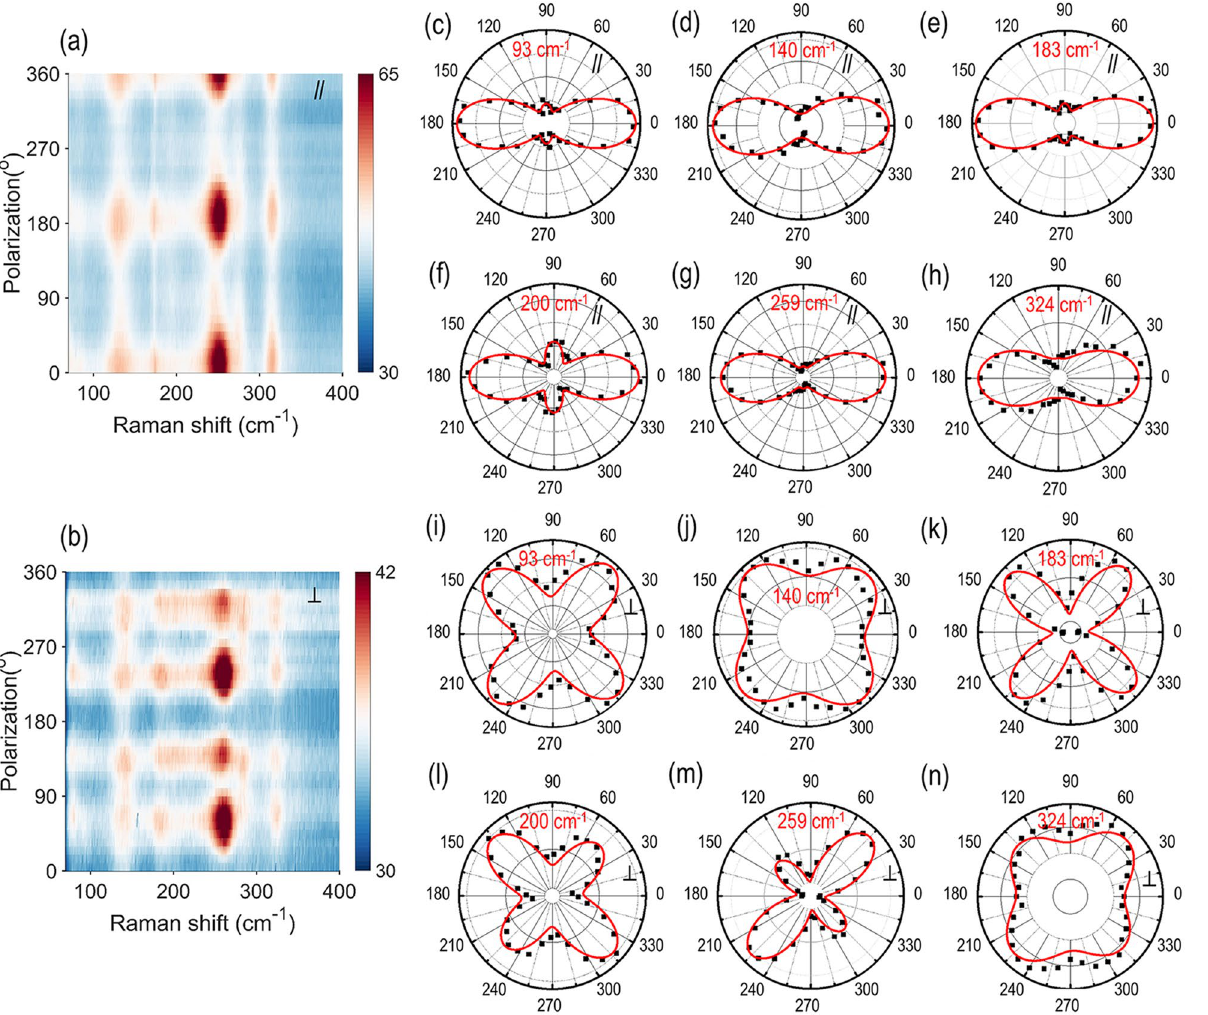
Figure 2. ( a , b ) Contour maps of angle-resolved polarized Raman spectra for the 138 nm-thick franckeite flake in the parallel (//) and perpendicular ( ⊥ ) configurations. ( c – h ) Polar plots of the Raman A g modes at 93, 140, 183, 200, 259 and 324 cm −1 in the parallel configuration. ( i – n ) Polar plots of the Raman A g modes in the perpendicular configuration. Black squares are the experimental data and red solid curves are the corresponding theoretical